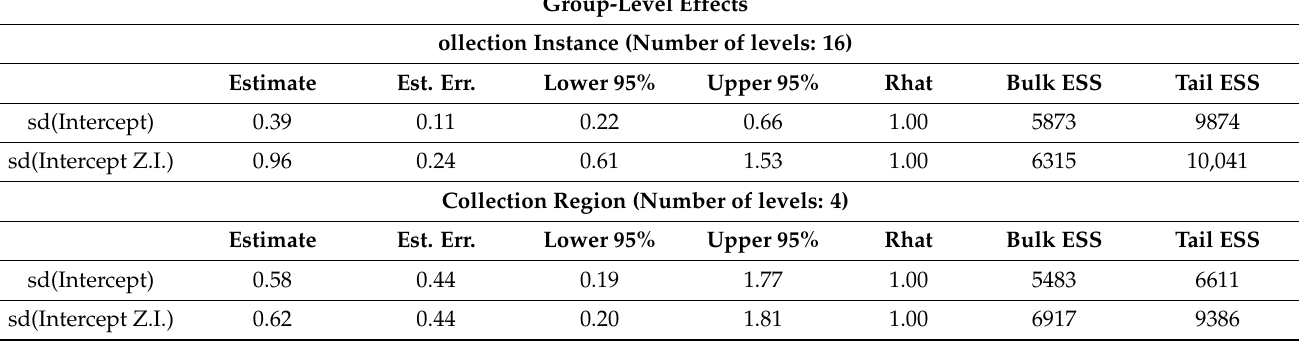
Table A6. Summary of Bayesian generalised linear model to assess the significance of season on mosquito eggs laid per felt. A model was fit to the mean of the negative-binomial response variable (log-link function) and simultaneously to the zero-inflation (Z.I.) probability (logit-link function). Ovitrap felt collections were grouped into 15 events over the four study areas, each of which con- tributed a random intercept to both models. Population-level effects were an intercept and the effect of a binary variable for season (0: December and January; 1: February to November) in both models. Columns for effects and estimated parameters are posterior mean estimate (“Estimate”); standard error of the posterior mean (“Est. Err.”); lower limit of the 95% Bayesian credible interval (“Lower 95%”); upper limit of the 95% Bayesian credible interval (“Upper 95%”); Gelman-Rubin convergence statistic (“Rhat”); bulk effective sample size for the estimate (“Bulk ESS”); and the tail effective sample size of the estimate (“Tail